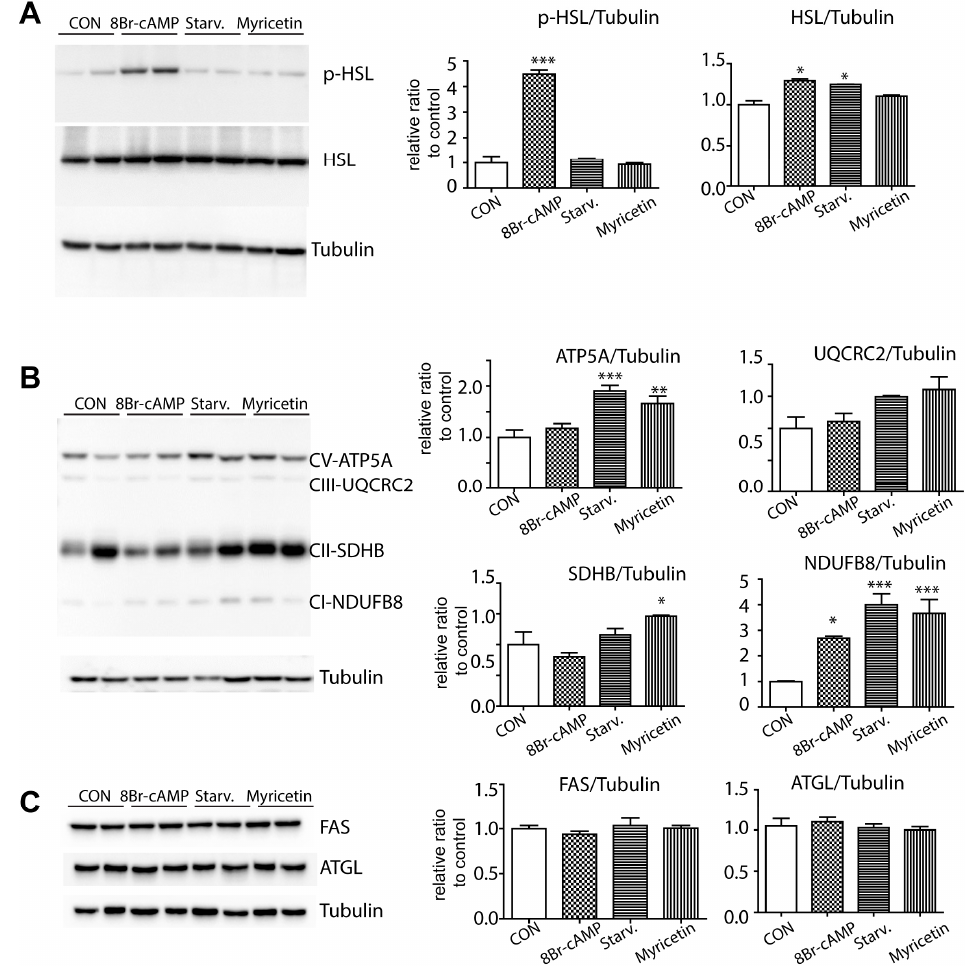
Figure 2. In vitro effects of myricetin on protein kinase A (PKA) signaling and mitochondrial content in adipocytes. ( A – C ) Immunoblot analysis of phosphor form of hormone sensitive lipase (p-hormone-sensitive lipase (HSL)), HSL, mitochondrial enzymes involved in oxidative phosphorylation, fatty acid synthase (FAS), and adipose triglyceride lipase (ATGL) in adipocytes differentiated from C3H10T1/2 cells treated with vehicle controls (CON), starvation medium (Starv.), 8Br-cAMP (1 mM) and myricetin (10 µ M) for 24 h. ( n = 4, means ± SEM, * p < 0.05, ** p < 0.01, *** p < 0.001).